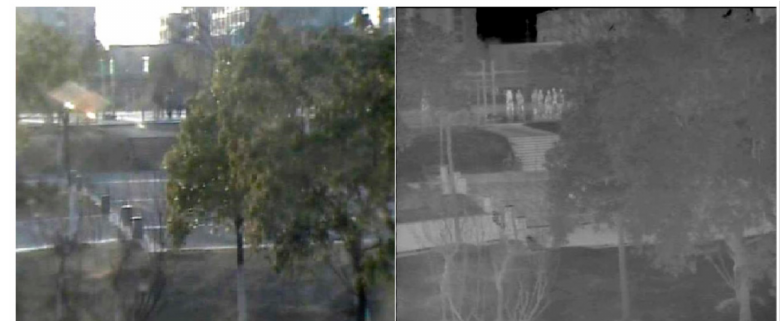
Figure 2. RGB image ( left ) and TIR image ( right ) under strong light conditions.